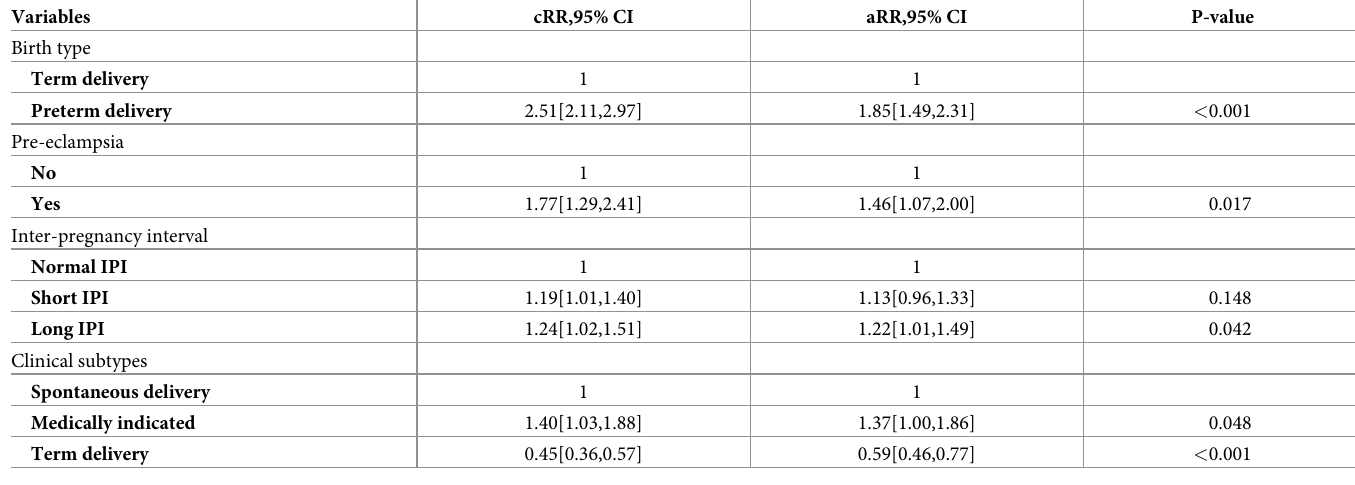
Table 5. Factors for recurrence of preterm birth delivery by women characteristics in previous pregnancy (N =